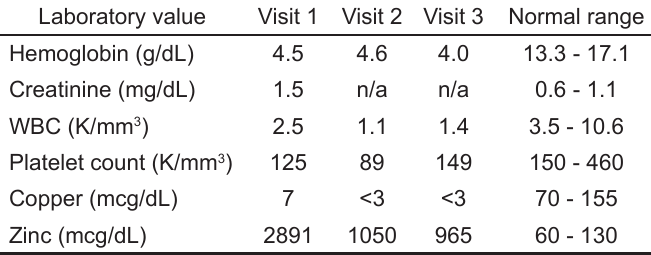
Table 2 . Elimination kinetics for the three modalities of